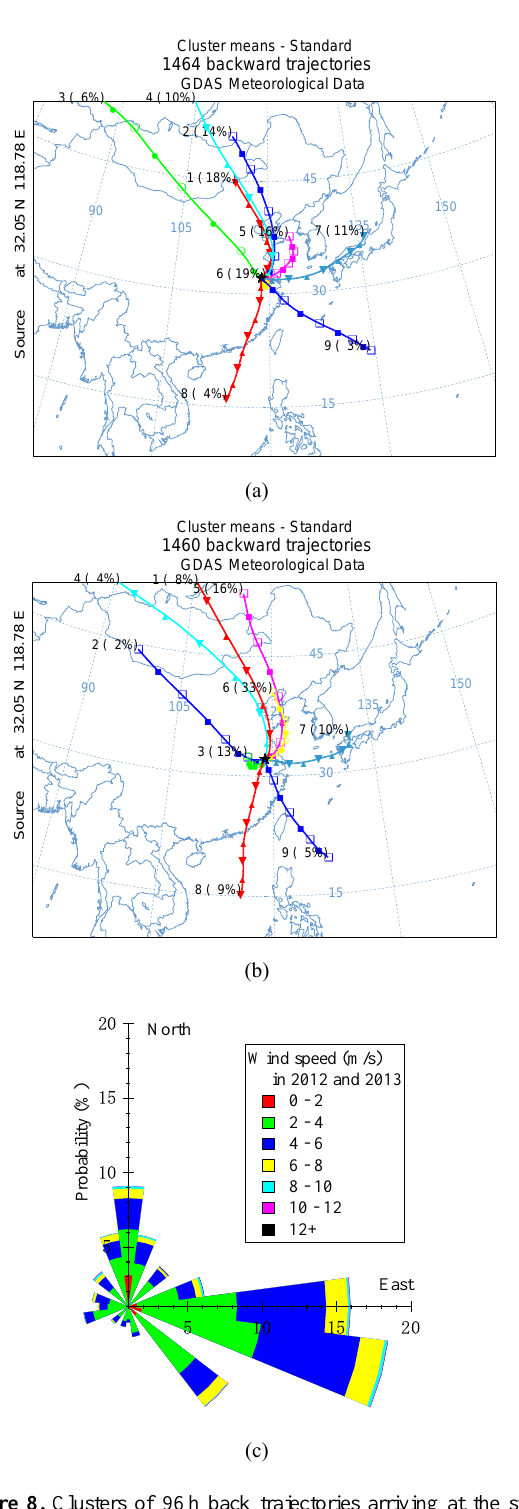
Figure 8. Clusters of 96h back trajectories arriving at the study site at 100m in 2012 (a) and 2013 (b) simulated by the HYSPLIT model and the probability distributions of 6h interval near-surface wind speed in different wind directions in Nanjing (c) .